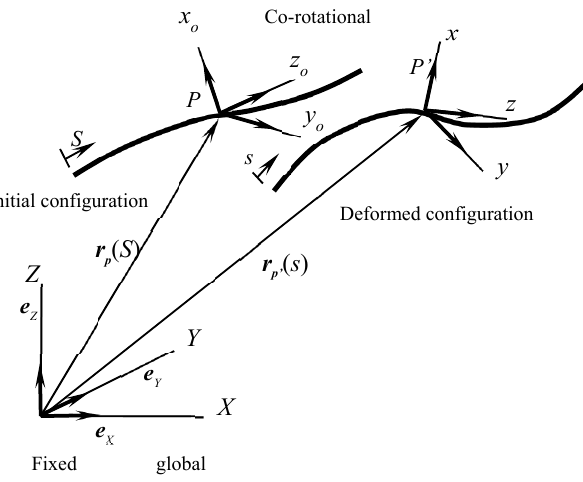
Figure 1. Coordinate systems of the co-rotational beam.